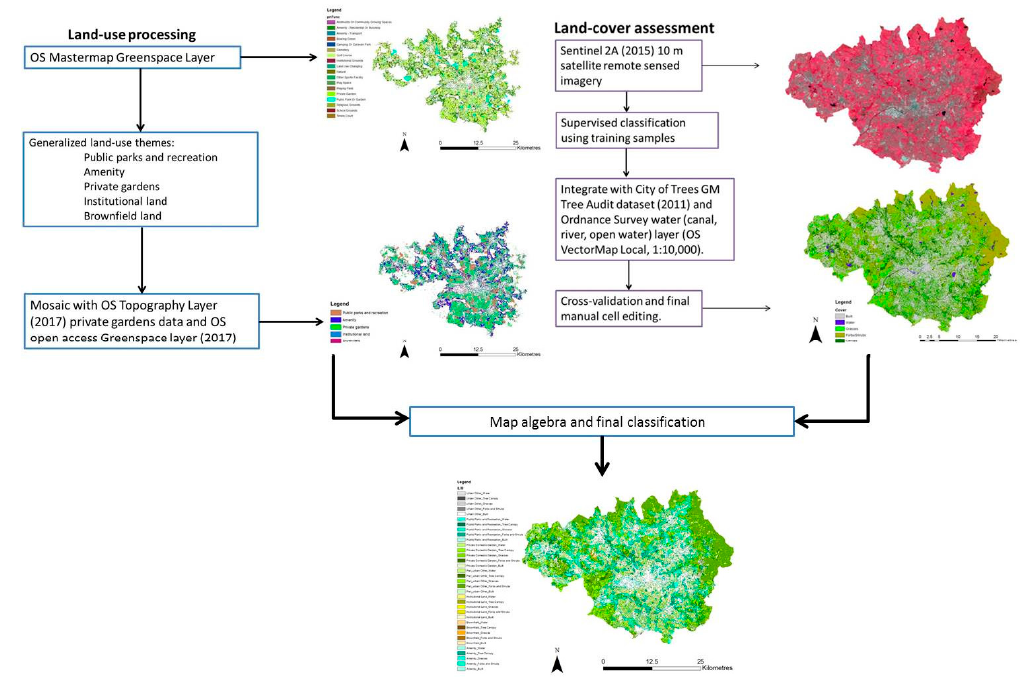
Figure 1. Data processing workflow.